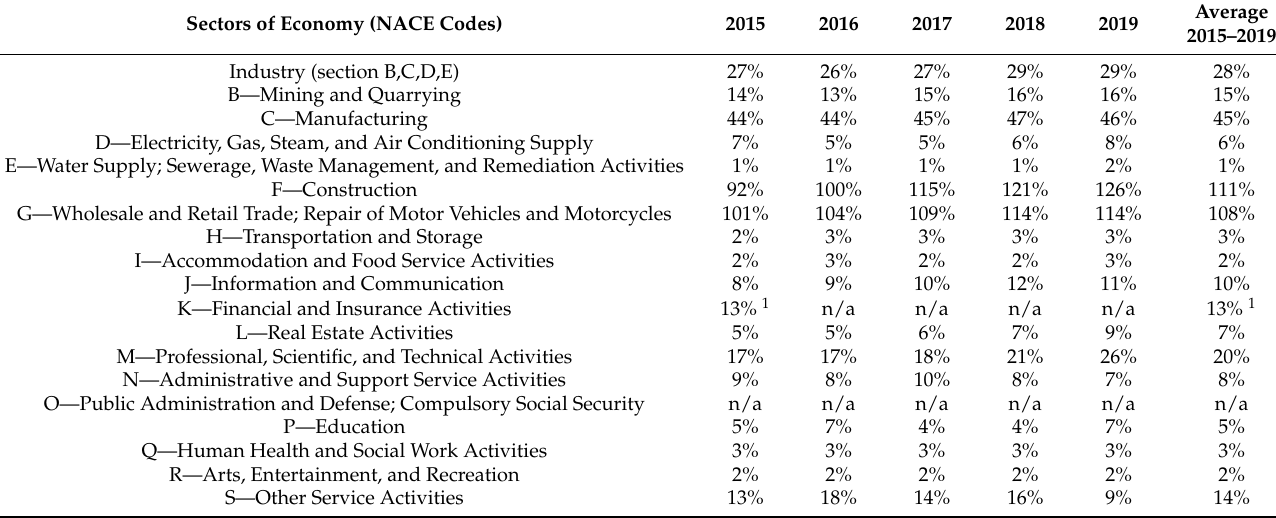
Table 4. Ratios of the value of stocks to the value of fixed assets in individual sectors of the economy. Sectors of Economy (NACE